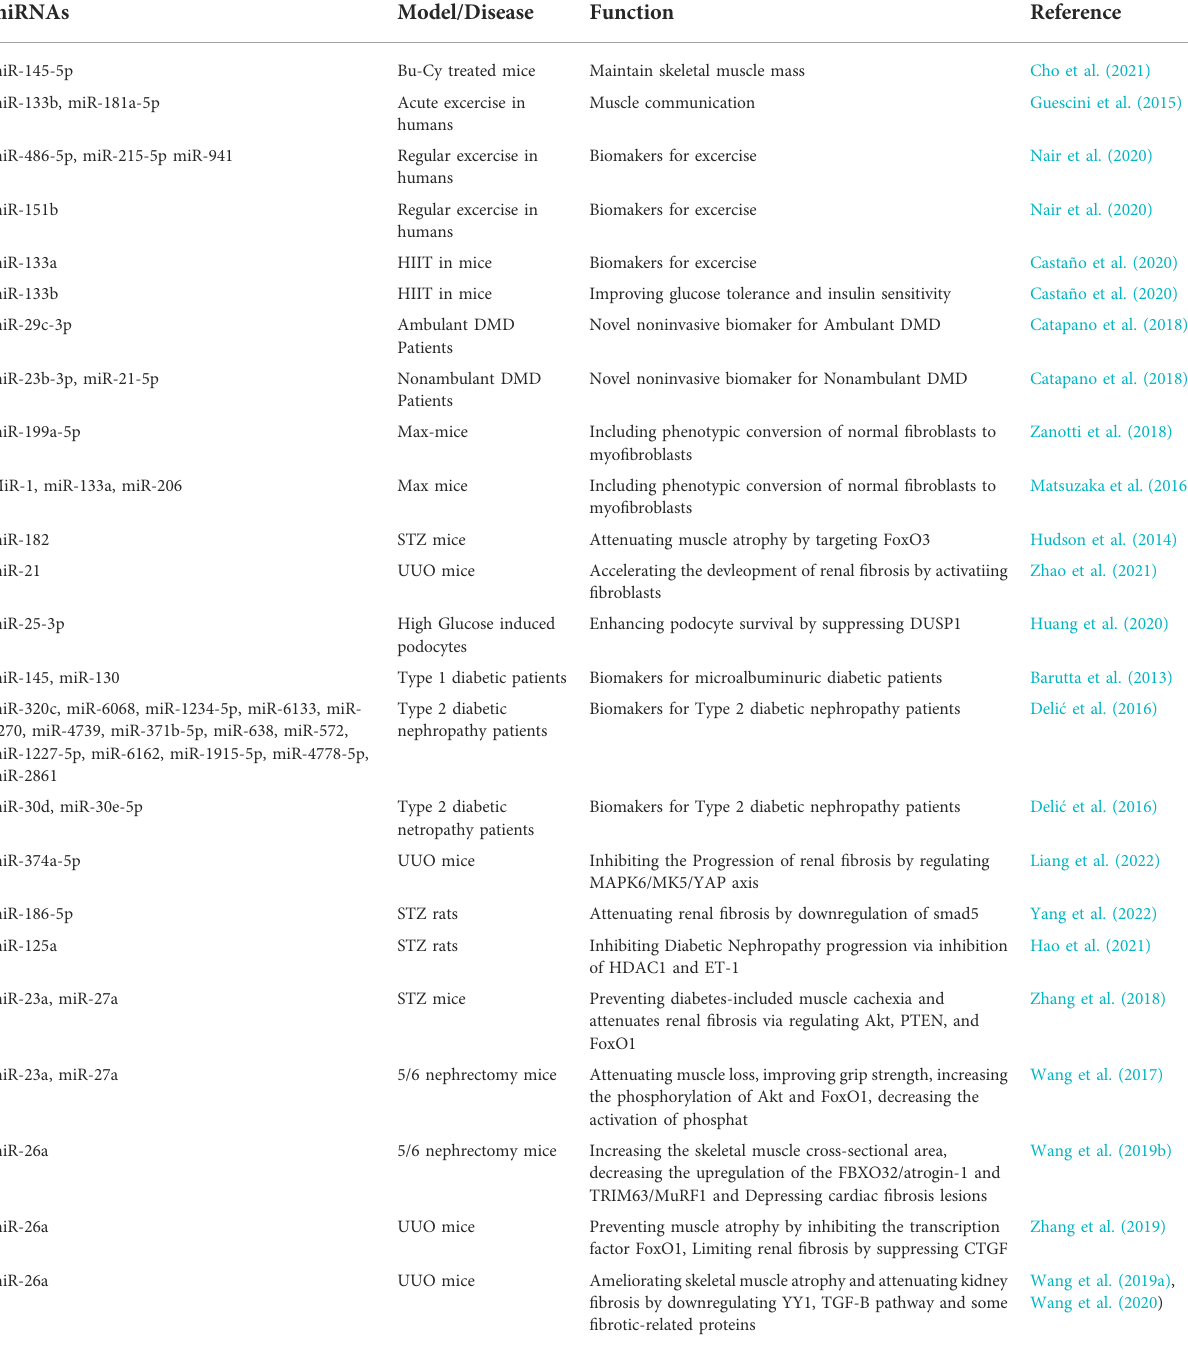
TABLE 1 Exosomal miRNAs in Muscle and/or Kidney miRNAs Model/Disease